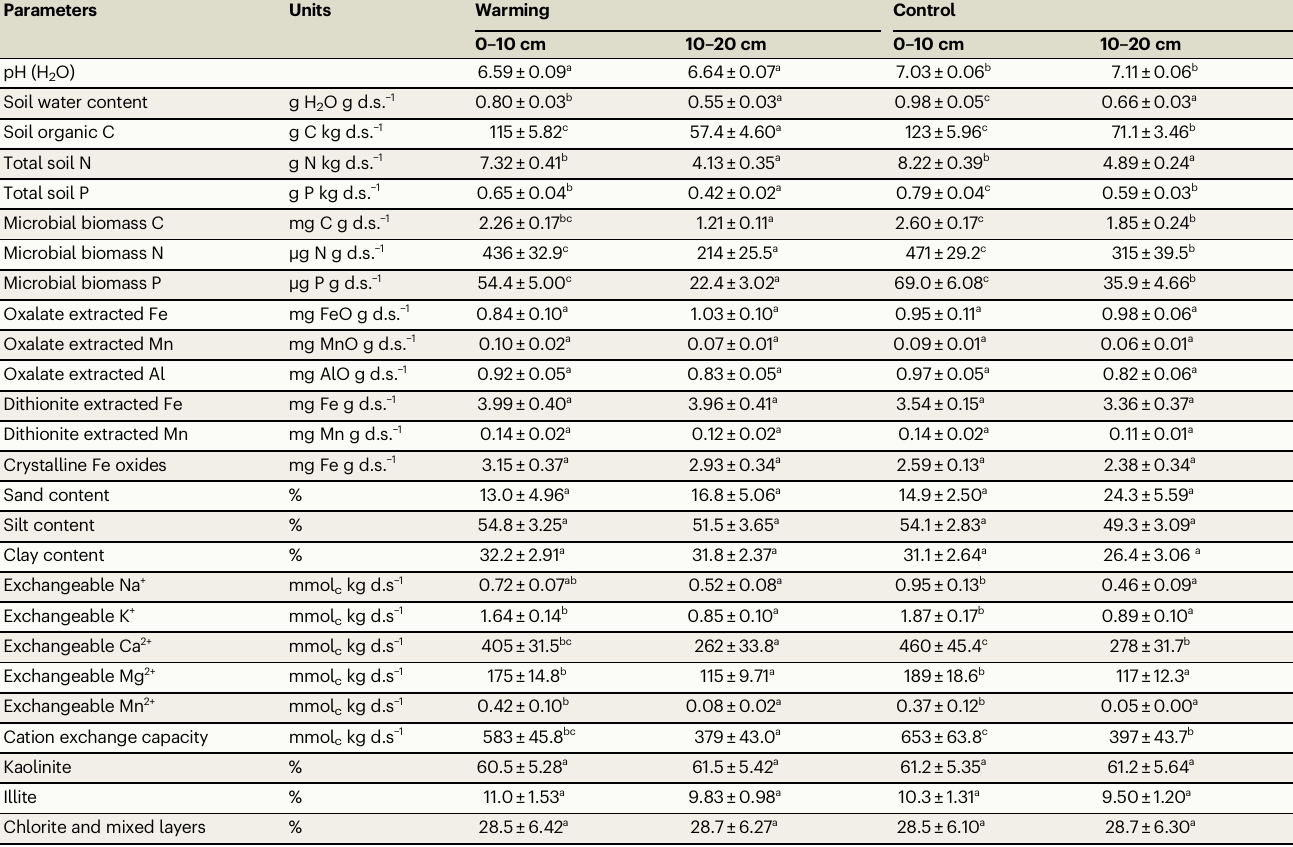
Table 1 | Comparison of soil properties at 0 – 10 cm and 10 – 20 cm depth in the warming and control